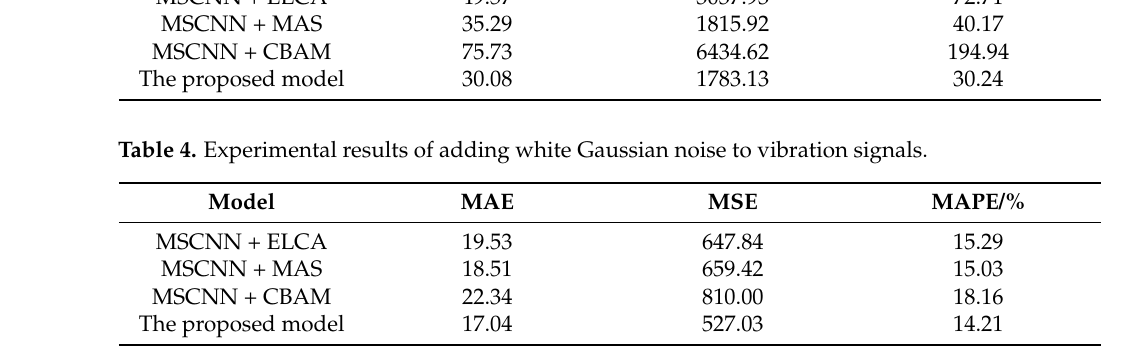
Table 5. Experimental results of adding white Gaussian noise to all